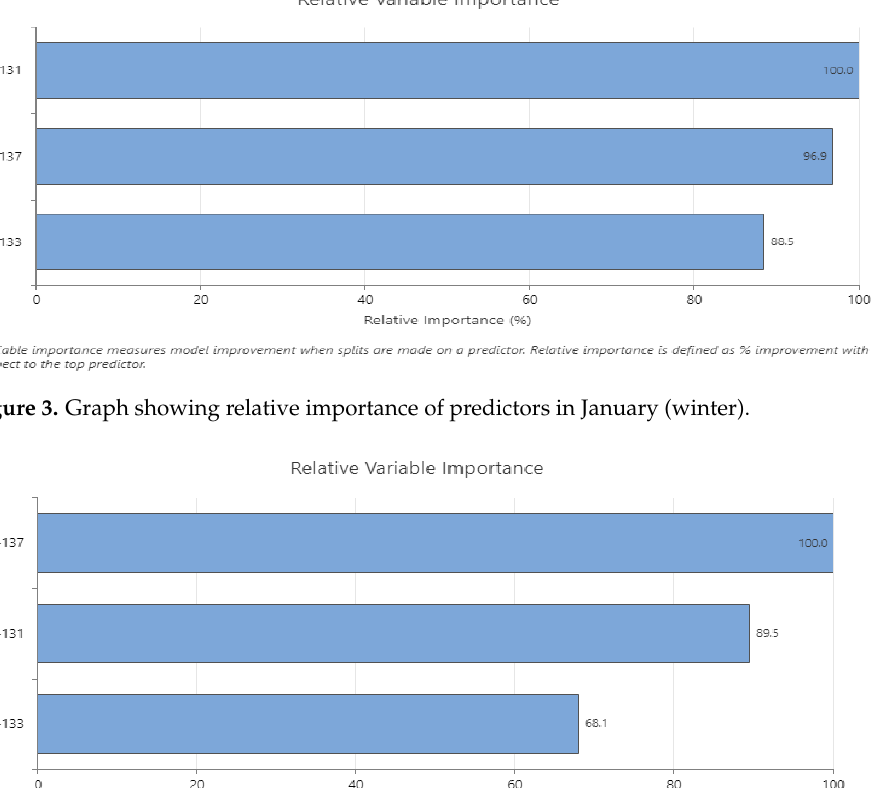
Figure 2. Graph showing the relative importance of the predictors for August (summer) .